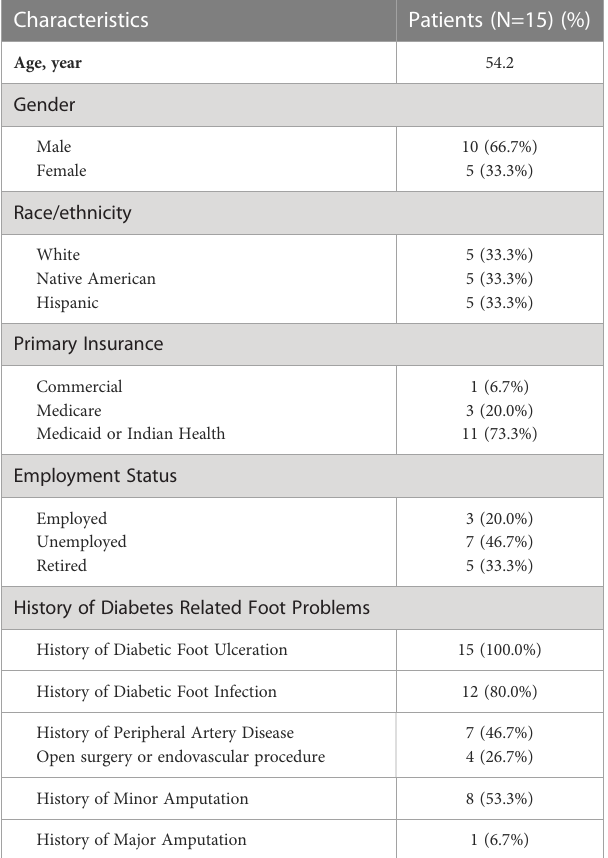
TABLE 1 Participant demographics (N=15).